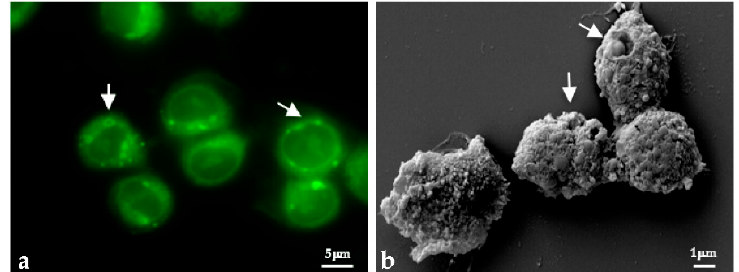
Figure 10. SKBR3 treated with Vepris macrophylla EO at 24 h with 1.25 μ g/mL ( a ) fluorescence mi-